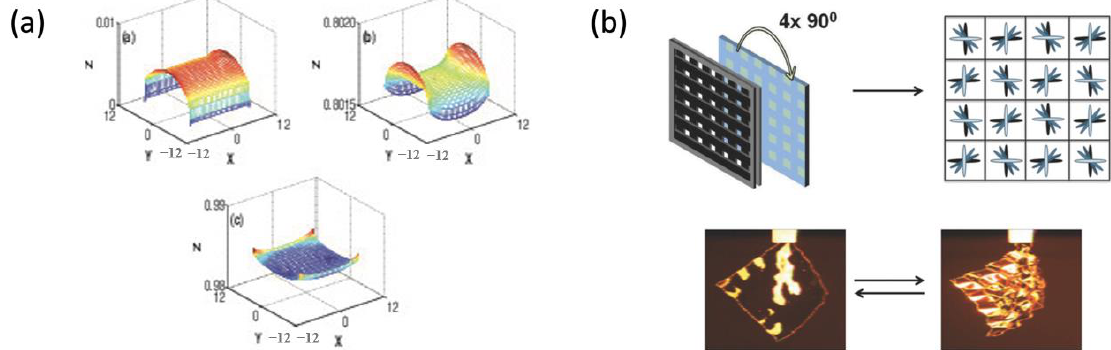
Figure 13. Examples of non-Galerkin-based FE model: ( a ) dynamics of stimuli-induced shape change (Adapted with permission from Ref. [103]. 2021, Zhu, W. et al.), ( b ) evolution of topography analyzed based on nemato-elasto-dynamics model. With the upper 1 × 4 patterns (red) 90-degree counterclockwise rotated 3 times, the LC films for the test are generated (4 × 4) (Adapted with permission from Ref. [37]. 2021, Haan, L.T. et al.).